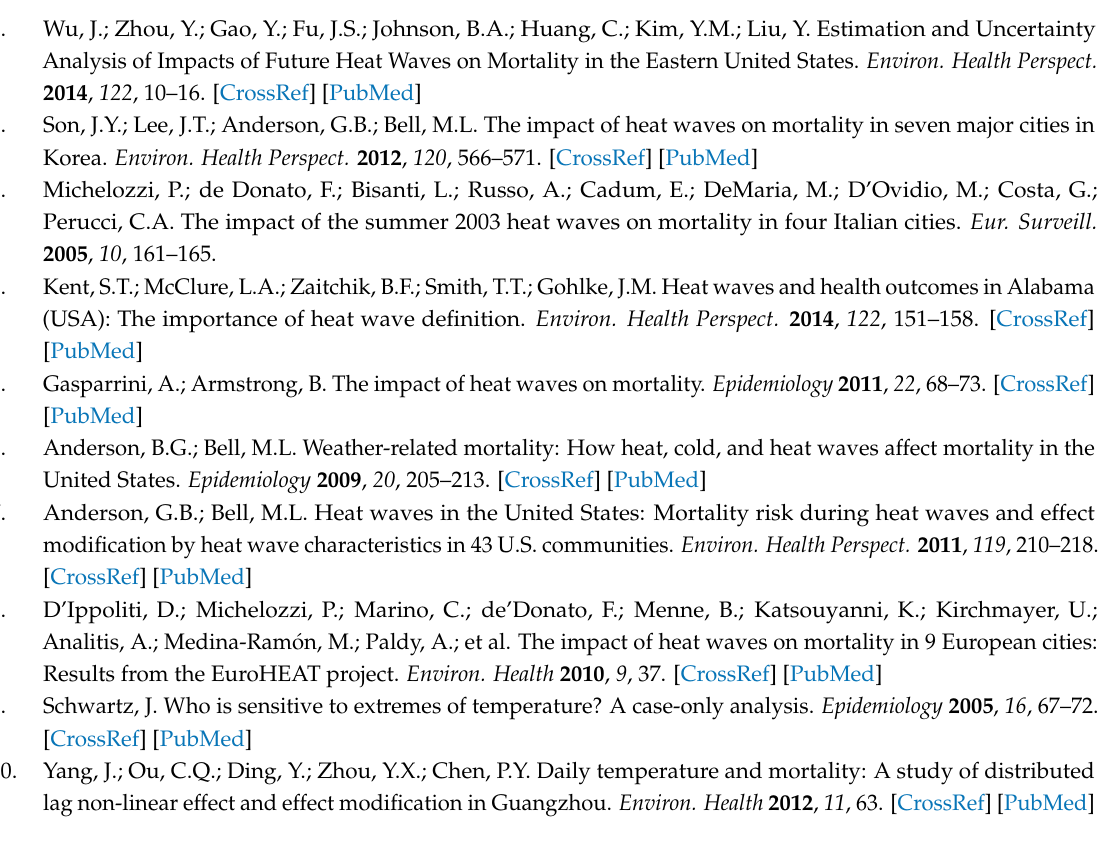
Supplementary Materials: The following are available online at www.mdpi.com/1660-4601/14/10/1143/s1, Figure S1: Tertiles for air EQI in metropolitan counties in Alabama. Non-metropolitan counties are white. Tertile 1: counties with the best air qualities in metropolitan areas; tertile 2: counties with median level air qualities; tertile 3: counties with the worst air qualities, Figure S2: Tertiles for water EQI in metropolitan counties in Alabama. Non-metropolitan counties are white. Tertile 1: counties with the best water qualities in metropolitan areas; tertile 2: counties with median level water qualities; tertile 3: counties with the worst water qualities, Figure S3: Tertiles for land EQI in metropolitan counties in Alabama. Non-metropolitan counties are white. Tertile 1: counties with the best land environments in metropolitan areas; tertile 2: counties with median level land environments; tertile 3: counties with the worst land environments, Figure S4: Tertiles for built EQI in metropolitan counties in Alabama. Non-metropolitan counties are white. Tertile 1: counties with the best built environments in metropolitan areas; tertile 2: counties with median level built land environments; tertile 3: counties with the worst built environments, Figure S5: Tertiles for sociodemographic EQI in metropolitan counties in Alabama. Non-metropolitan counties are white. Tertile 1: counties with the best sociodemographic environments in metropolitan areas; tertile 2: counties with median level sociodemographic environments; tertile 3: counties with the worst sociodemographic environments, Table S1: Coefficients for the Interaction term (mean and (95% CI)) comparing the associations between heatwave indices (HIs) and non-accidental death (NAD) in EQI tertile 2 and 3 to EQI tertile